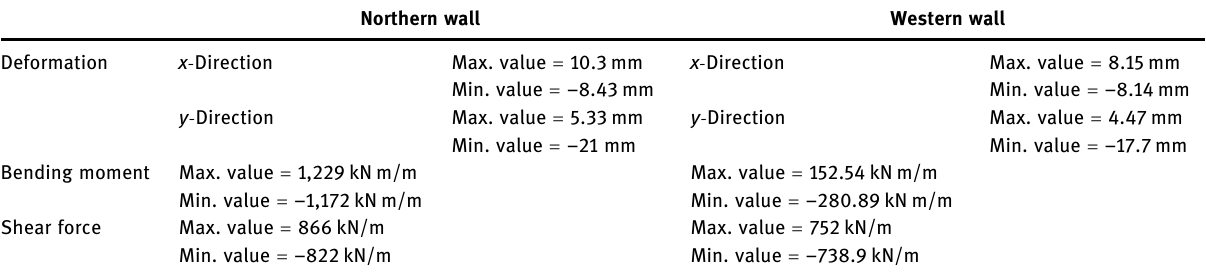
Table 3: Deformation, bending moment, and shear force values for the northern wall and western wall of the Al - Kufa Mosque